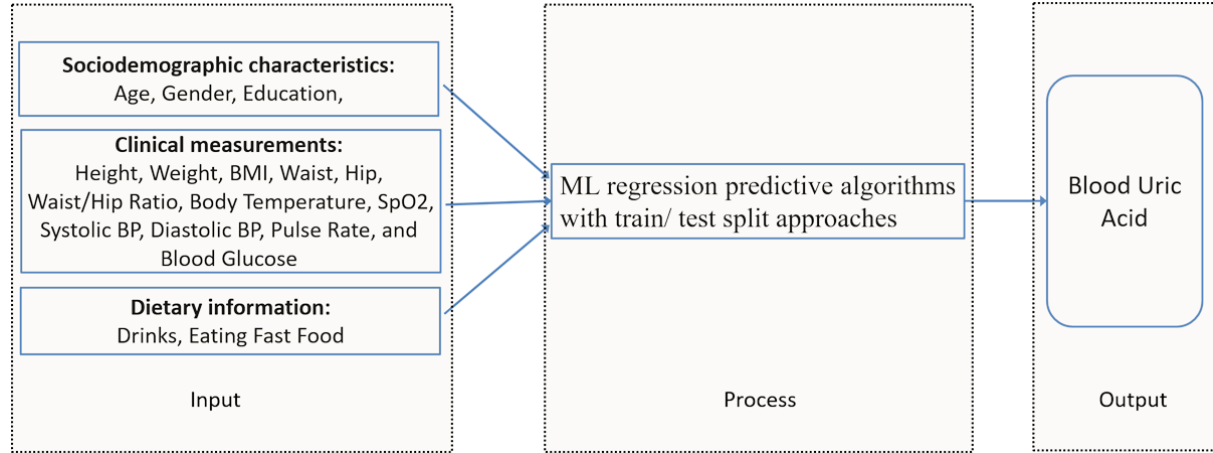
Figure 1. The input-process-output model used for predicting uric acid after processing 17 input variables by machine-learning (ML) algorithms. BP: blood